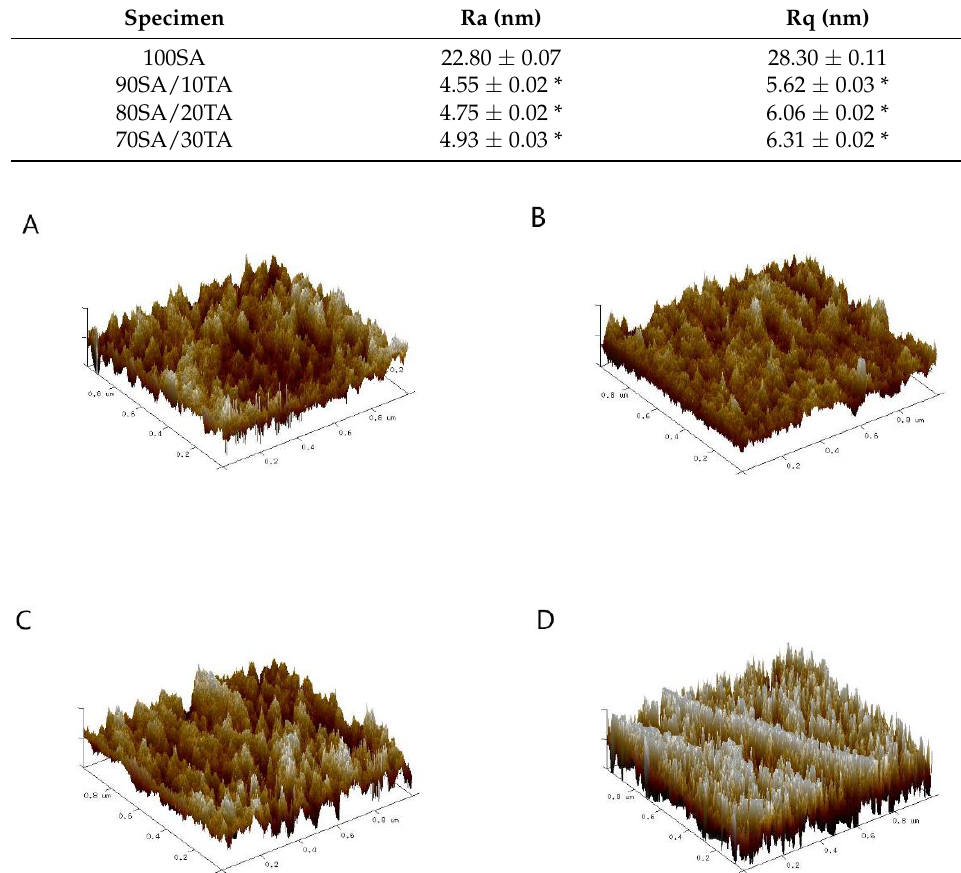
Figure 3. AFM three-dimensional images (1 µ m × 1 µ m) of ( A ) 100SA ( B ) 90SA/10TA ( C ) 80SA/20TA ( D ) 70SA/30TA (the presented images are representative for five specimens).